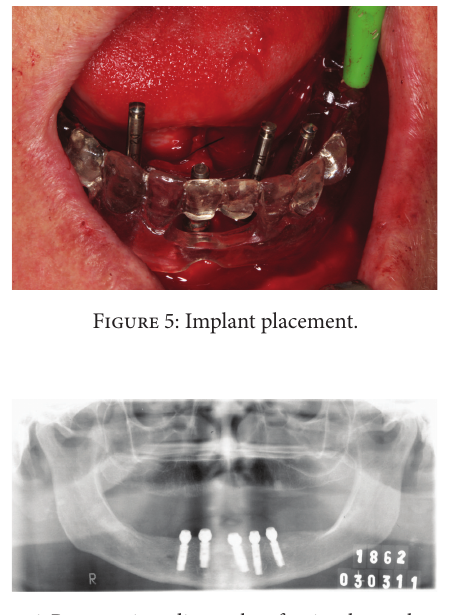
Figure 6: Panoramic radiography after implants